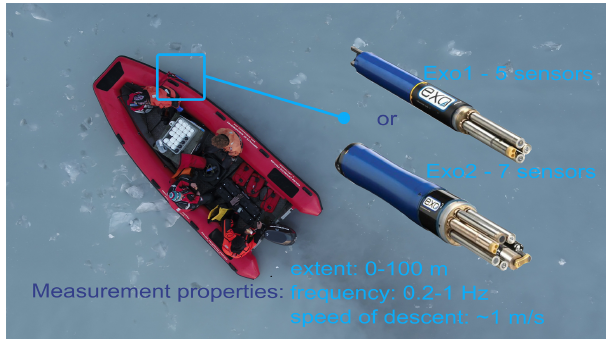
Figure 2. The images in the foreground (sourced from https: //observator.com/products/ysi-exo-series-multiparameter-sonde/, last access: 3 September 2022) present the sondes used to make the measurements, and the text at the bottom of the panel outlines the measurement properties. The background image shows scientists in a Zodiac boat during measurements of water properties; the water is visibly infused with turbid